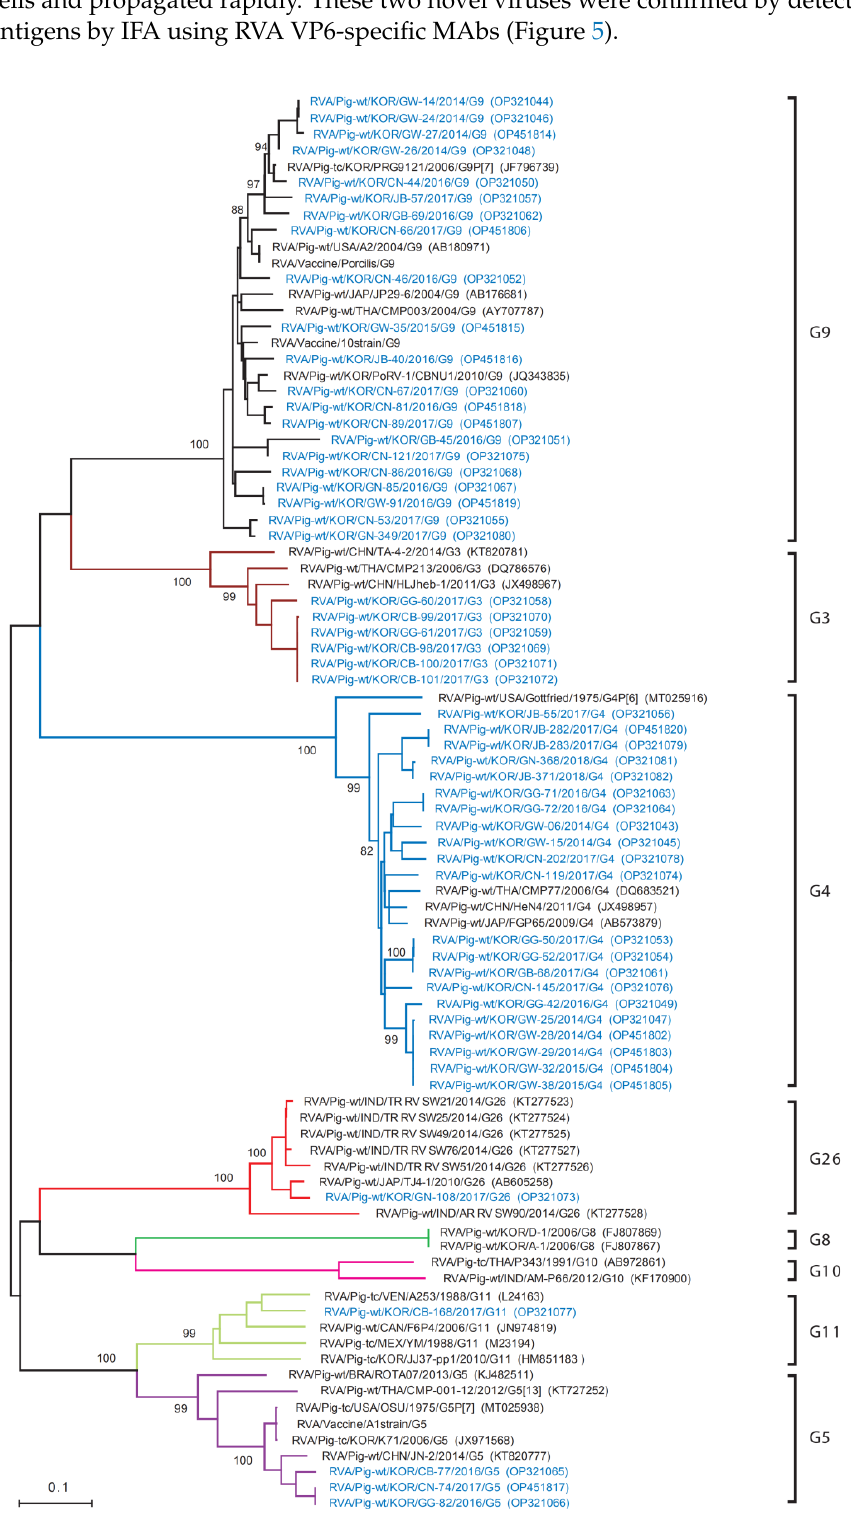
Figure 3. Phylogenetic analysis based on a partial nucleotide sequence of the VP7 gene from 53 PoRVA antigen-positive samples and selected reference strains. The phylogenetic tree was reconstructed using the maximum-likelihood (ML) method (based on the Tamura 3-parameter model) in the MEGA X program, and tested using 1000 bootstrap values. The 53 Korean PoRVA isolates identified in this study are denoted by blue letters.